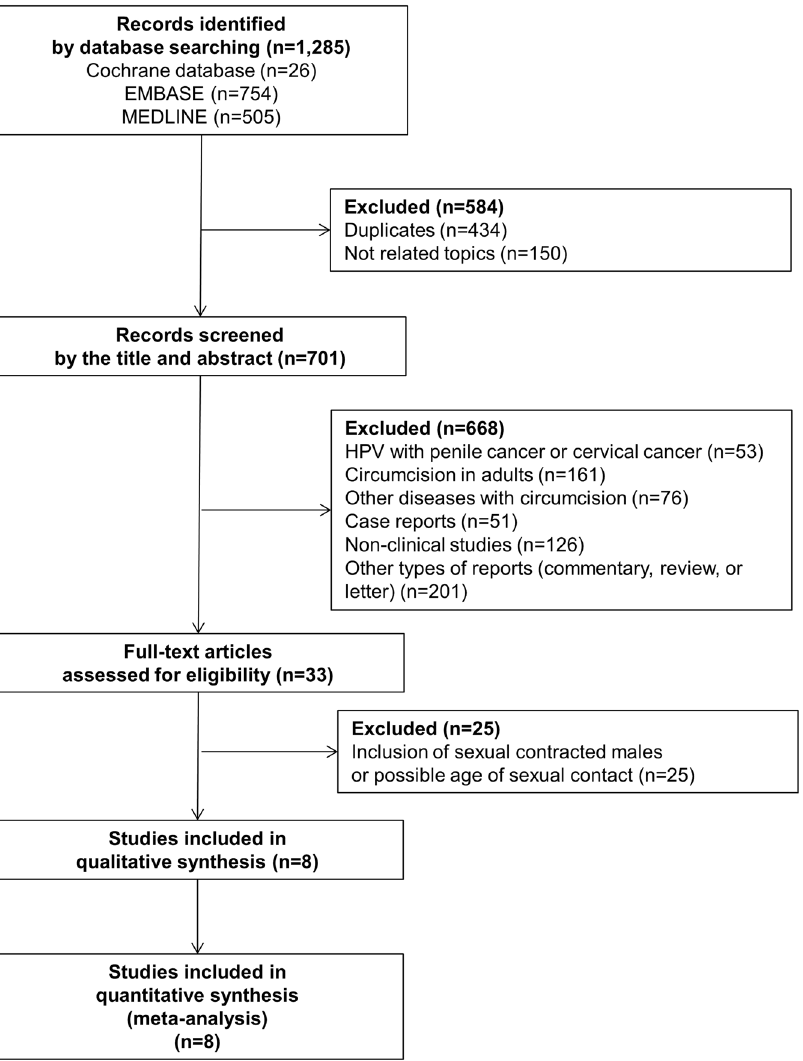
Figure 1. Flow chart of the included